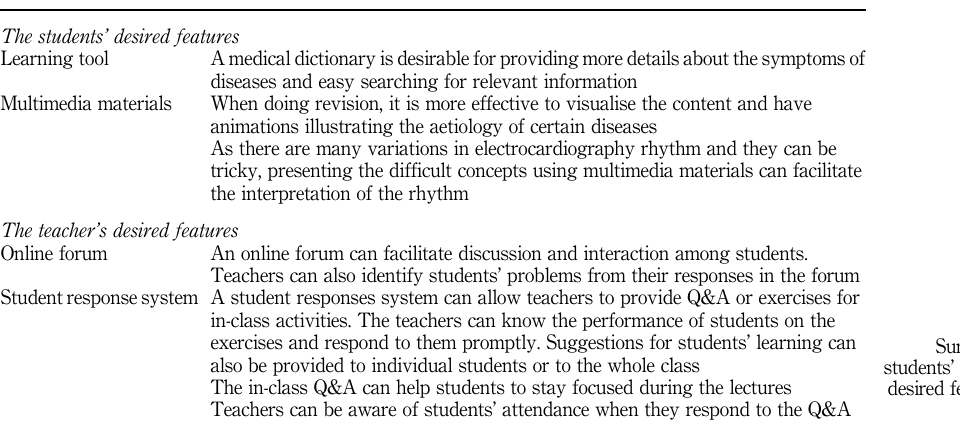
Table III. Summary of